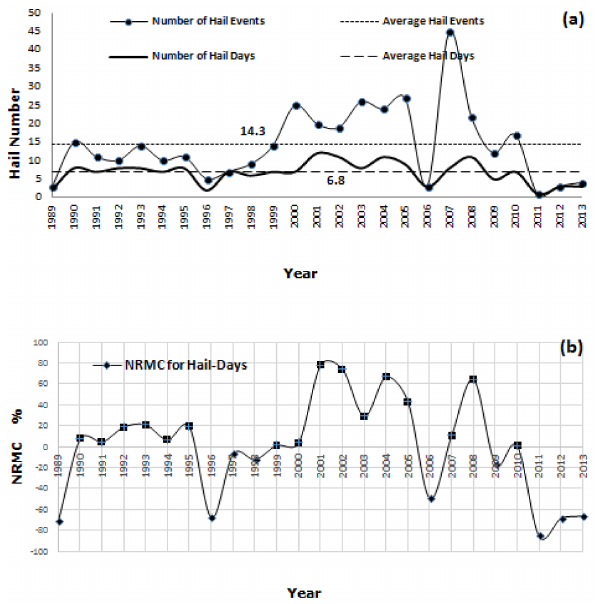
Figure 9. (a) Time series of the hail events (all severe hail reports inside of the study area per year) and associated hail days (days in which at least one severe hail event larger than 2cm observed) and (b) NRMC model for hail days reported on a longer time period.